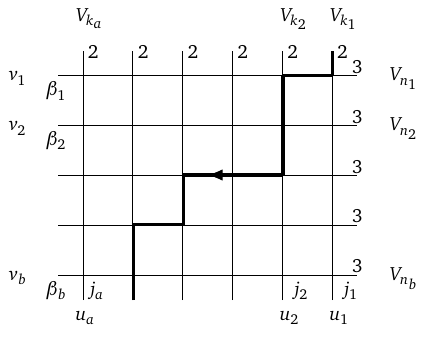
Figure 6: Line of the constant